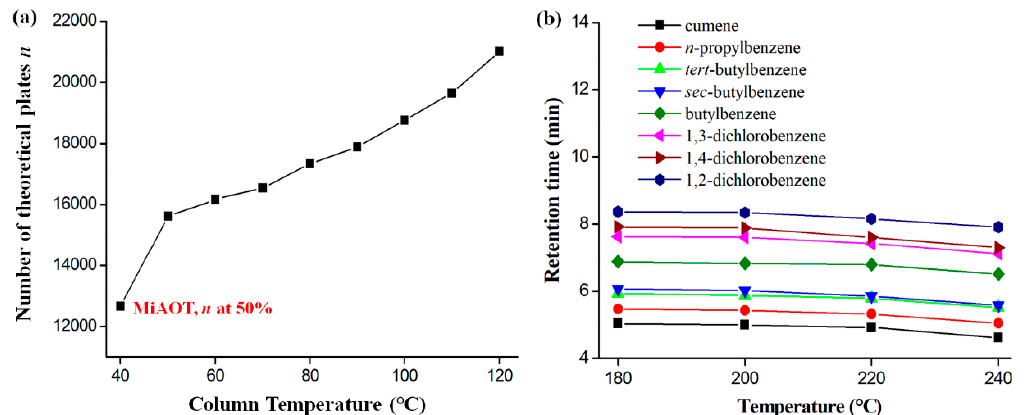
Figure 5. Determination of the minimum allowable operating temperature (MiAOT) was determined by naphthalene ( a ) and the thermal stability ( b ) of PCL-PEG-PCL column.